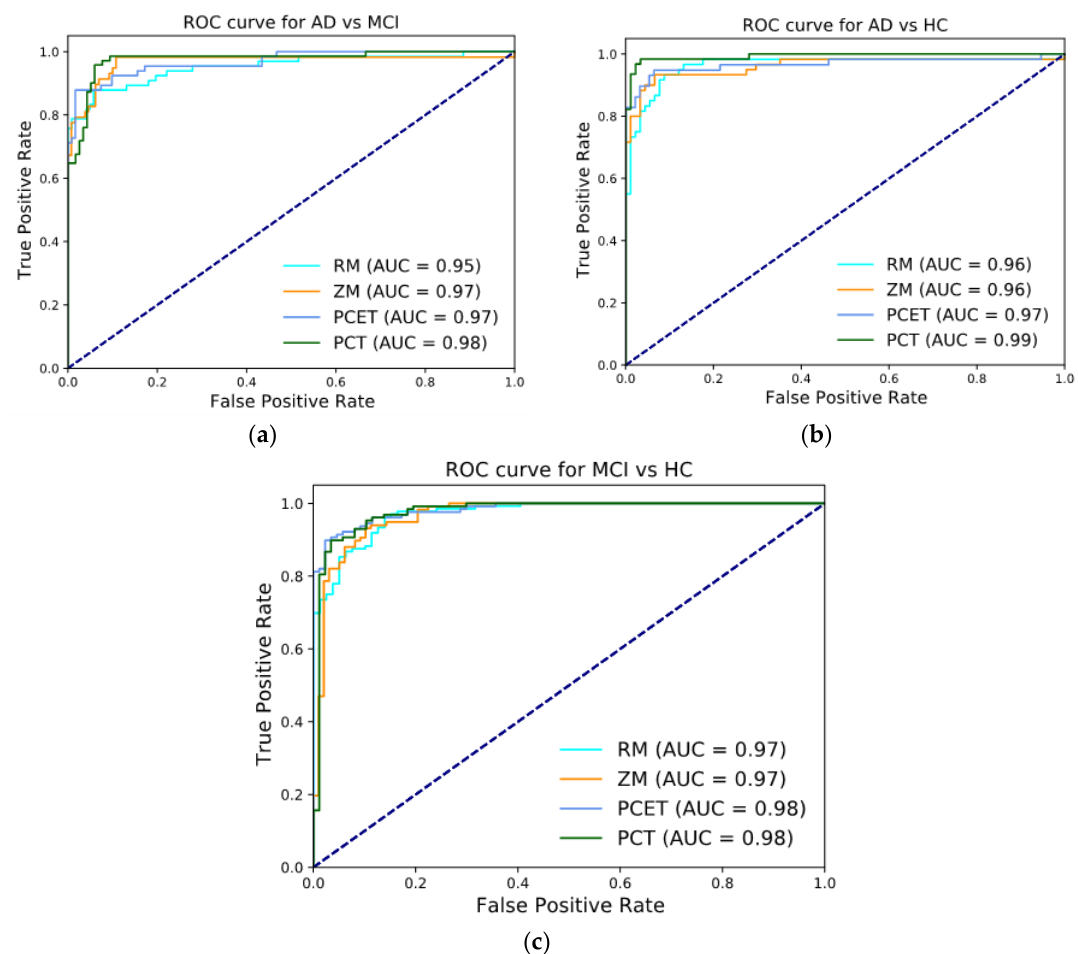
Figure 2. Receiver operating characteristics (ROC) curve for ( a ) Alzheimer’s disease (AD) vs. mild cognitive impairments (MCI), ( b ) AD vs. healthy controls (HC), and ( c ) MCI vs. HC.